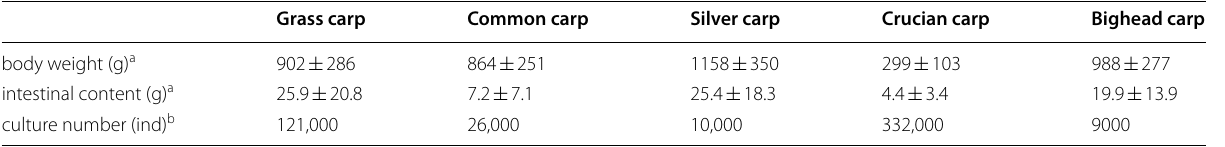
a Determined based on the sampled fish b The numbers of cultured fish species in the farm in 2020, which were calculated during the harvest season